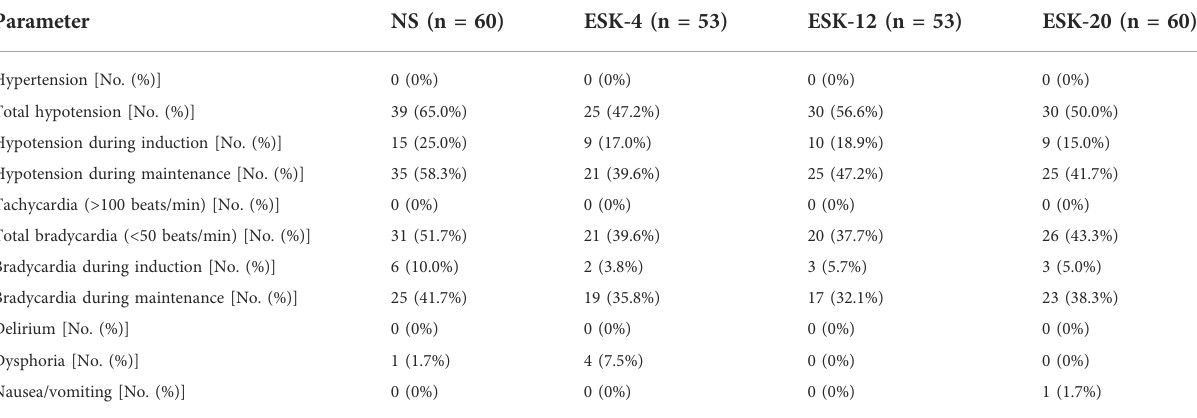
TABLE 5 Incidence of adverse events between the groups.